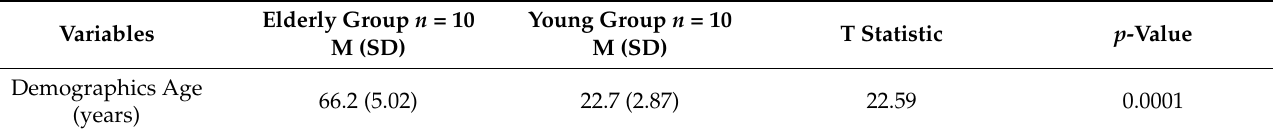
Table 1. Age information of elderly and young subjects.